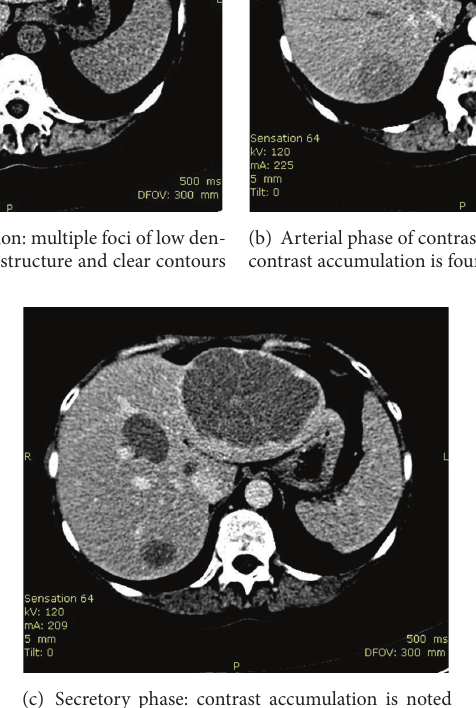
Figure 1: Abdominal